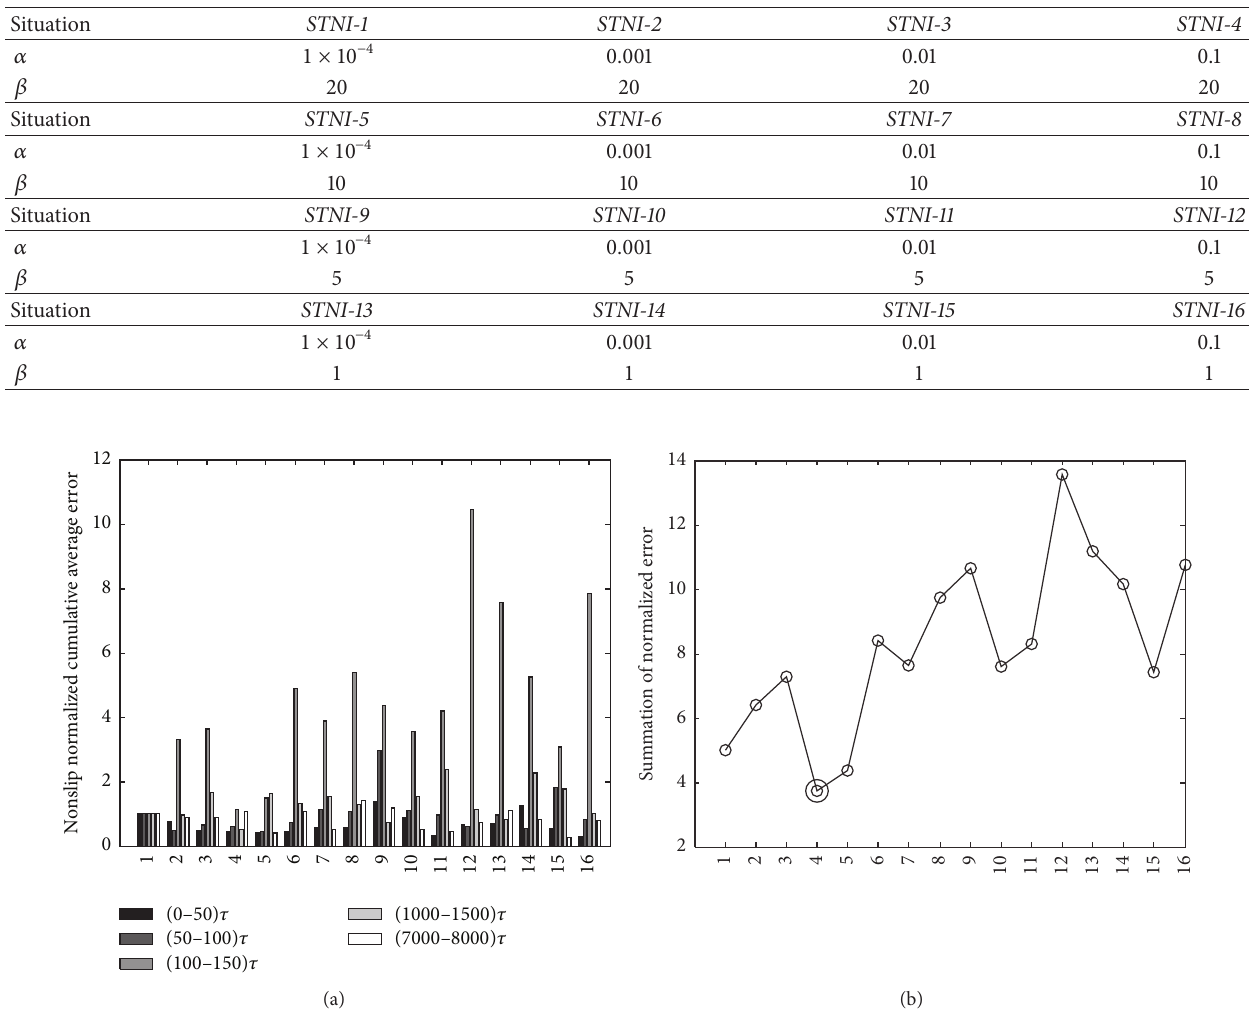
Figure 15: Differences among the sixteen situations using the results of “ STNI-1 ” as the normalized base (a) and summation errors over the five time intervals (b).